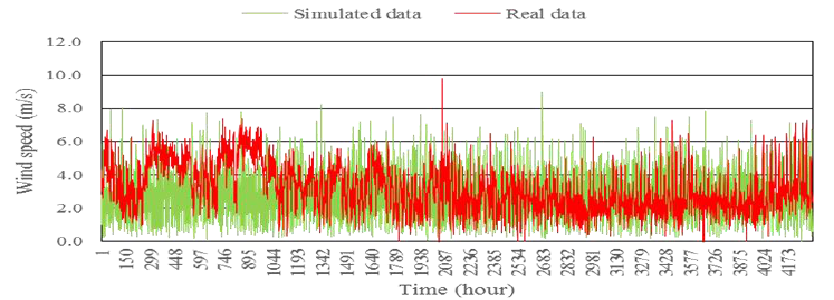
Figure 8. Comparison between real wind speed data and simulated wind speed data from the Weibull model for six months at Mersing in 2015.